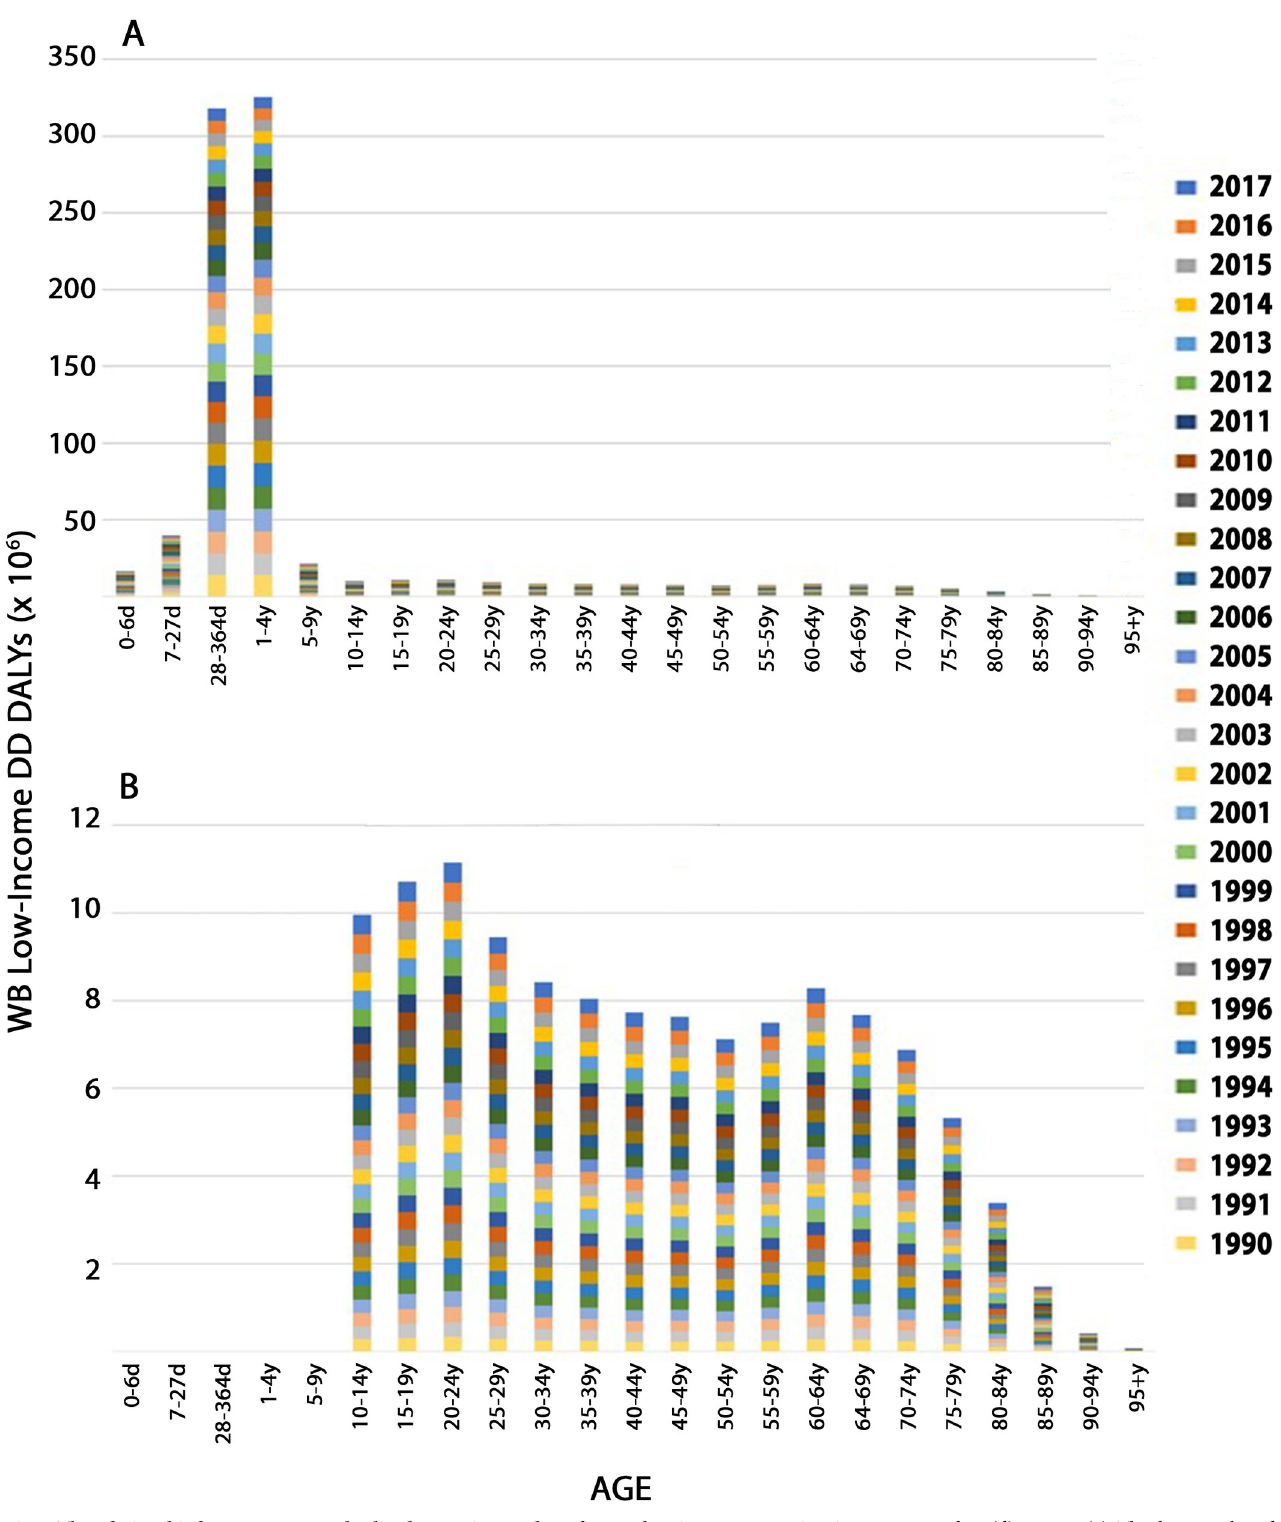
Fig 7. The relationship between age-standardized DD DALY and age for WB low-income countries. Age is given in days (d) or years (y). The data are plotted with (A) and without (B) data from the under 10-year-old age classes. For each age class (bar), the sum of annual DD DALYs from 1990–2017 are presented.